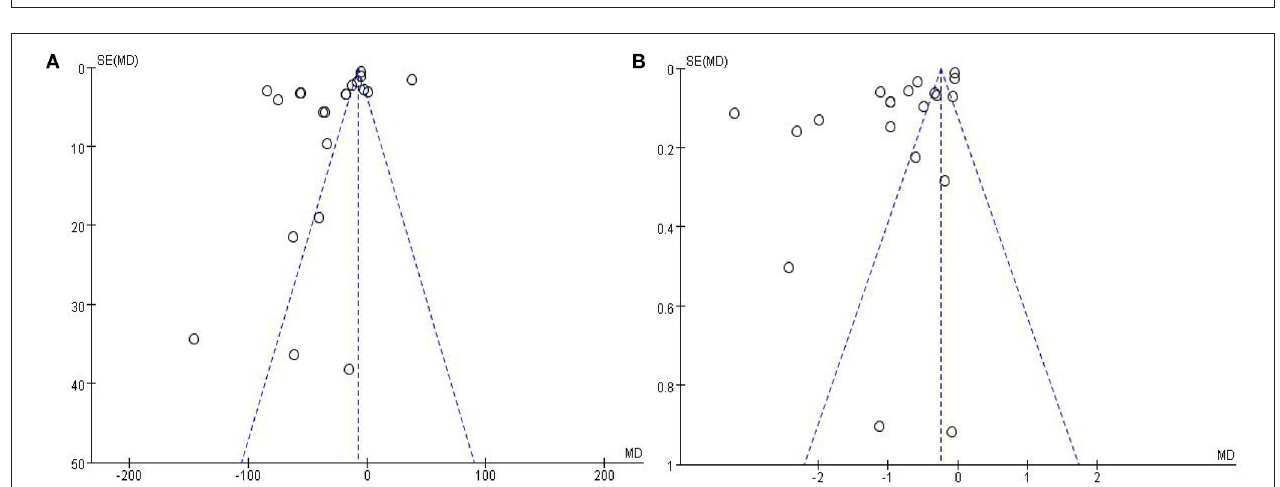
FIGURE 7 | Forest plot for the effects of melatonin on glutathione.